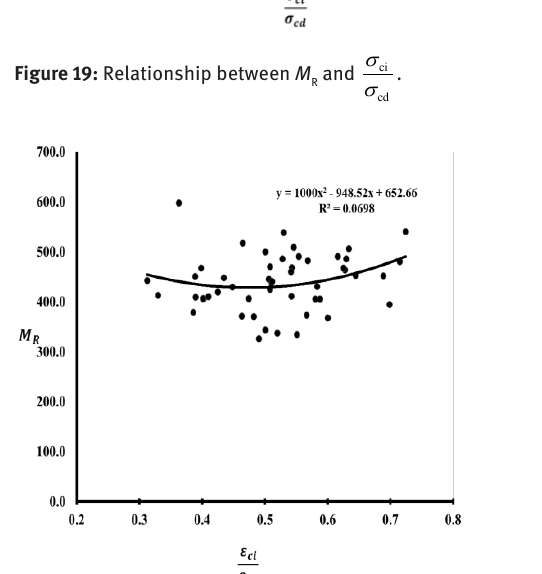
Fig. 16. Relationship between and 𝜀𝜀 𝑎𝑎 (cid:3) 𝑚𝑚𝑎𝑎𝑚𝑚 𝜎𝜎 𝑐𝑐𝑐𝑐 𝜎𝜎 𝑐𝑐 𝜀𝜀 𝑐𝑐𝑐𝑐